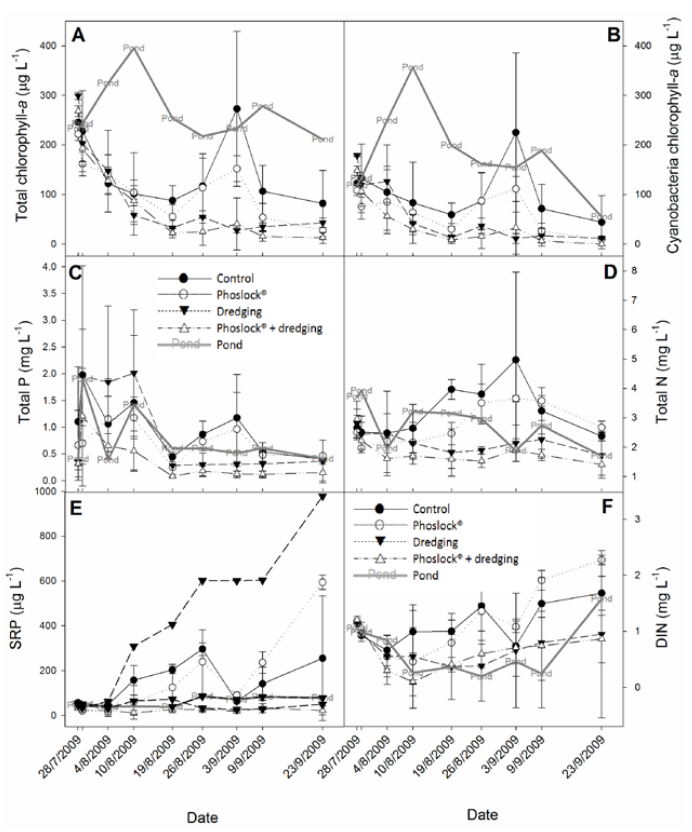
Figure A1. The course of the total chlorophyll- a concentrations (μg L − 1 ; Panel A ), cyanobacterial chlorophyll- a concentrations (μg L − 1 ; Panel B ), total P concentration (mg L − 1 ; Panel C ), total N concentration (mg L − 1 ; Panel D ), SRP concentration (μg L − 1 ; Panel E ), and DIN concentration (mg L − 1 ; Panel F ) in control enclosures, Phoslock ® -treated enclosures, dredged enclosures, combination Phoslock ® -treated and dredged enclosures, and the pond over the 58-d experimental period in 2009. Error bars indicate one standard deviation ( n = 3). In Panel E the dredged enclosures are depicted individually.